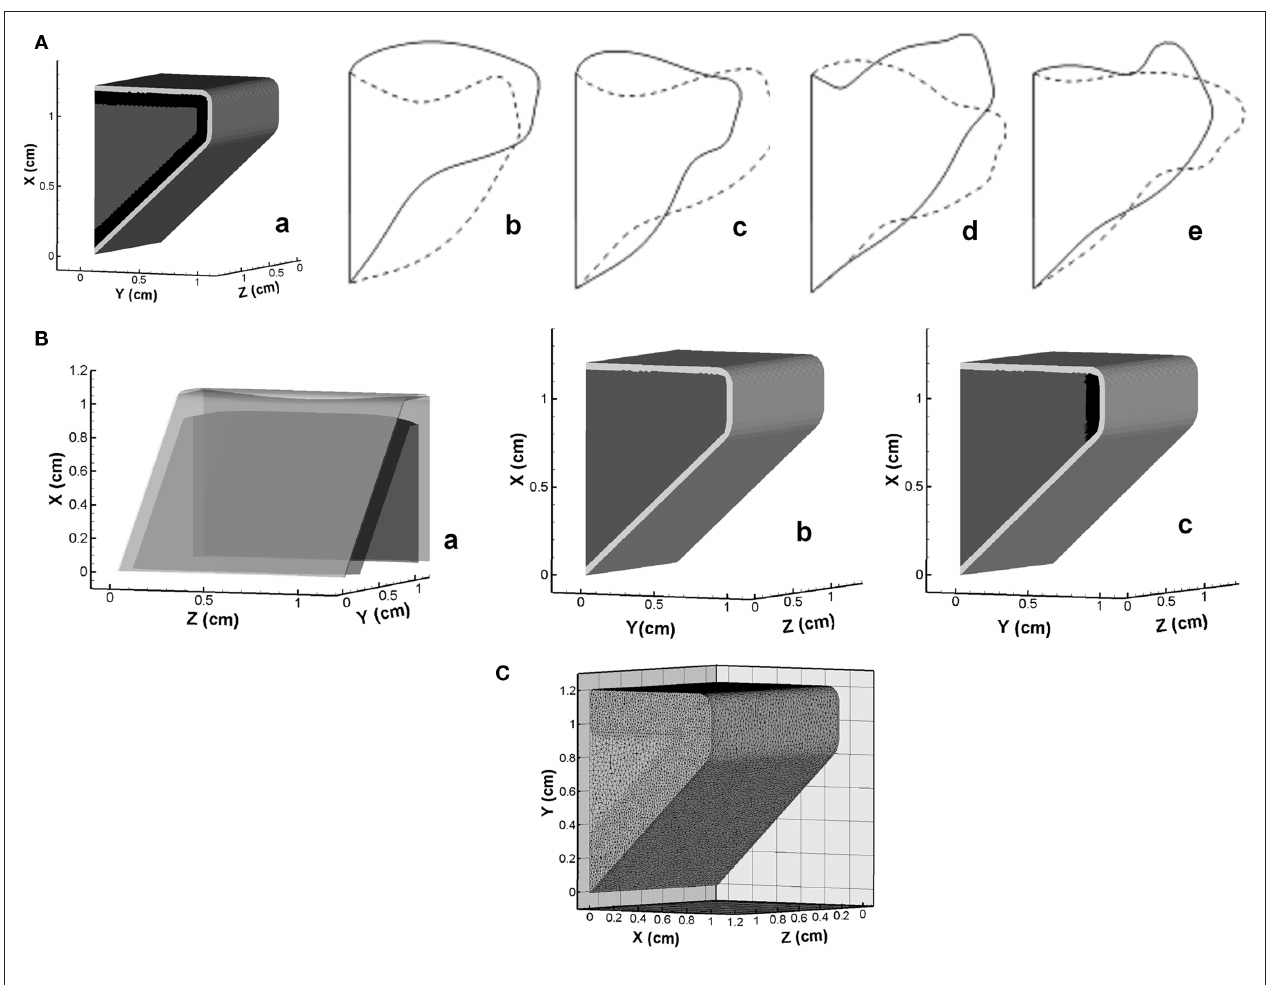
Figure 13 | (A) Three-dimensional vocal fold model and mid-coronal views of the first four eigenmodes. (a) Geometry model; (b) Mode-1; (c) Mode-2; (d) Mode-3; (e) Mode-4. (B) Schematics of inner structure of variant vocal fold